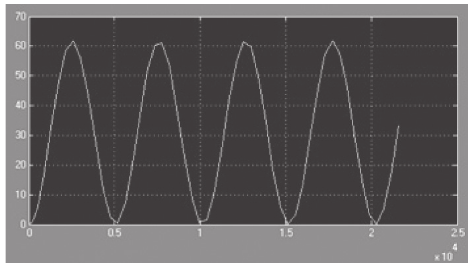
Fig. 5. The maximum error of one channel of an inertial